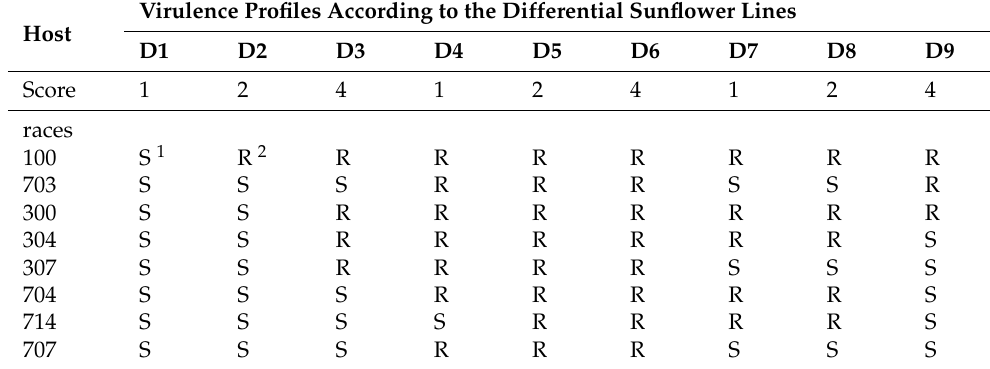
Table 1. Races of P. halstedii as defined by the differential lines of sunflower (D1–D9). Virulence Profiles According to the Differential Sunflower Lines Host